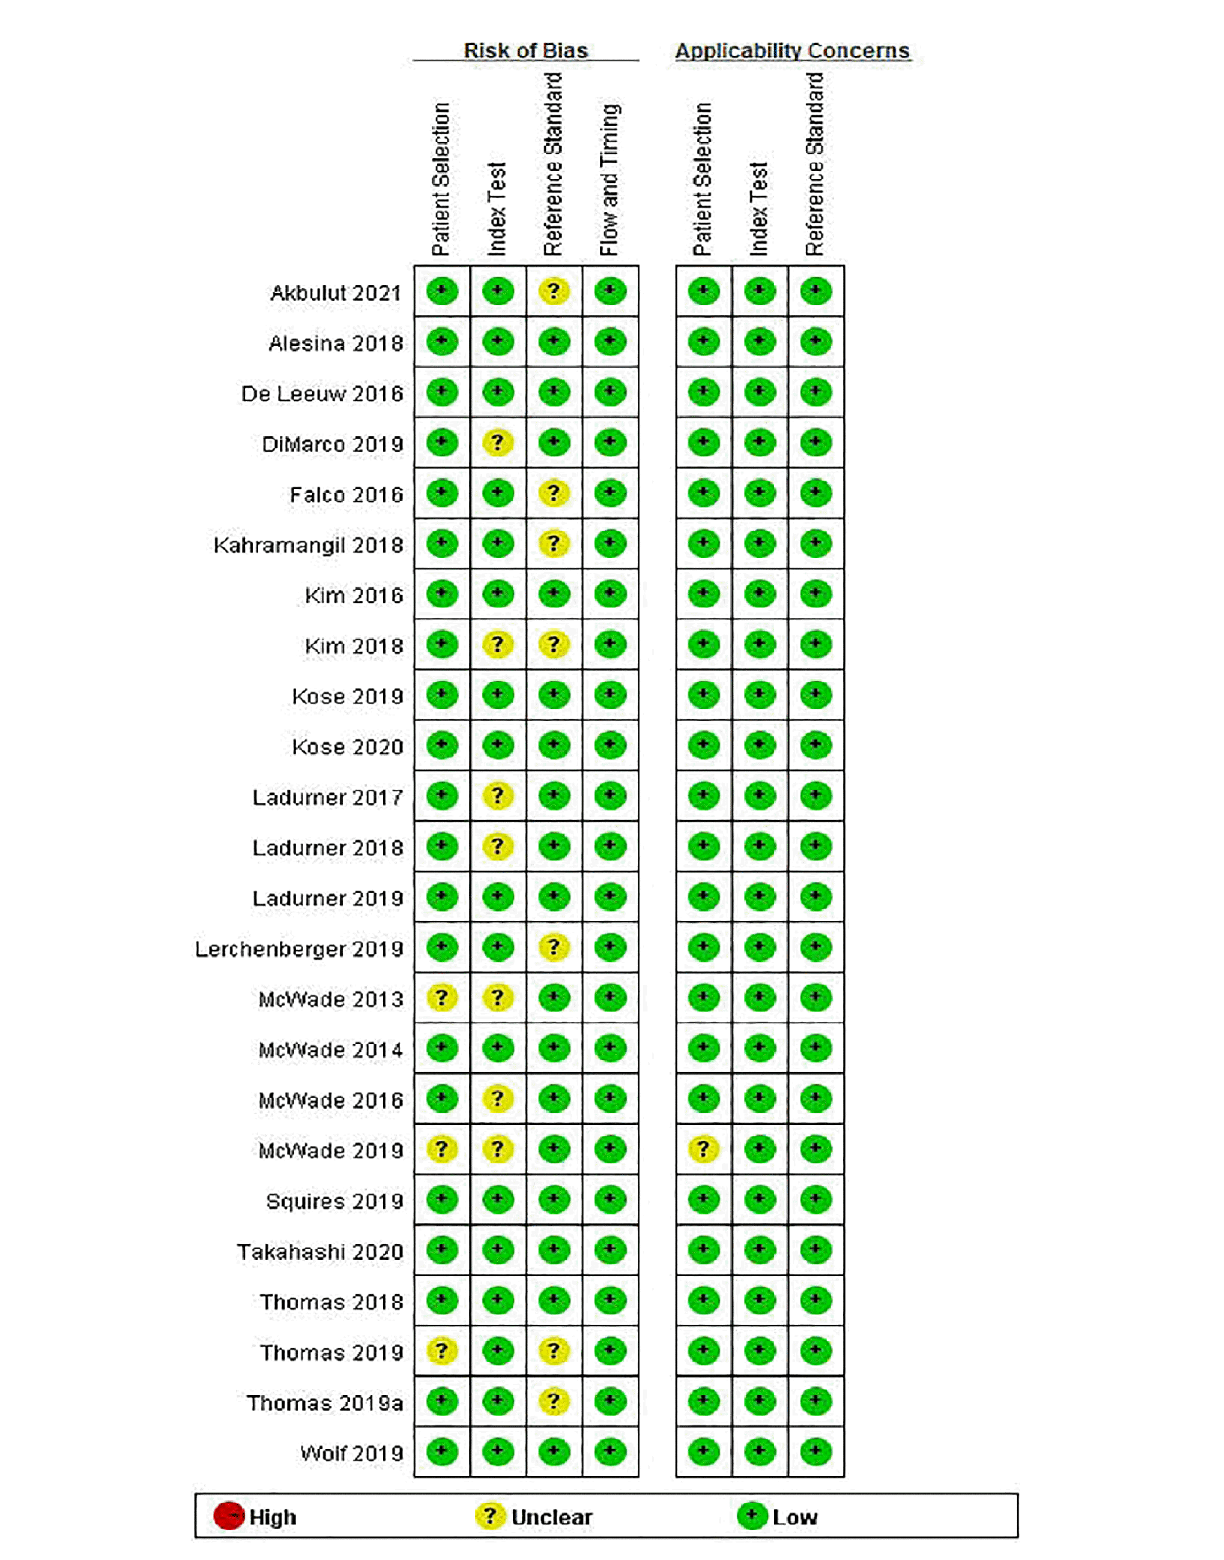
FIGURE 2 | Risk of bias and applicability concerns summary: review authors ’ judgements about each domain for each included study.